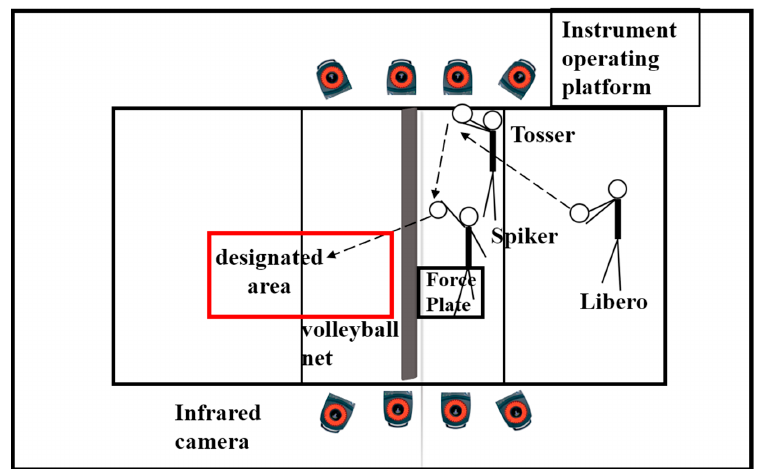
Figure 2. Illustration of the spike landing process.